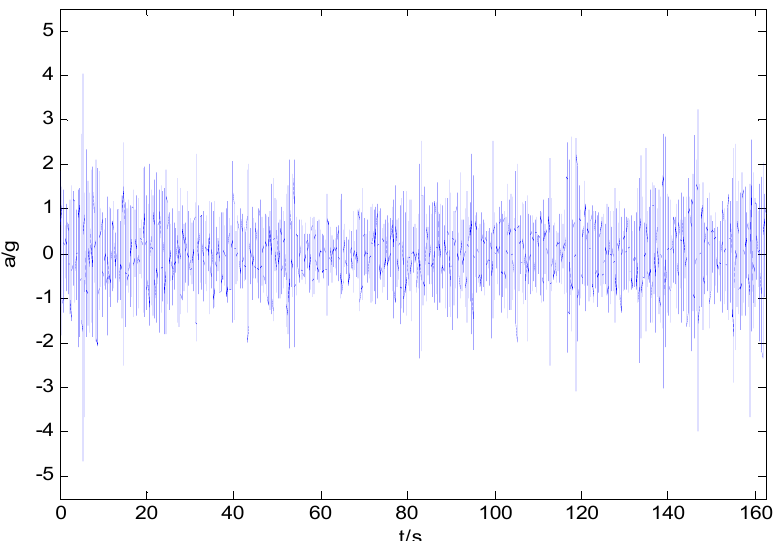
Figure 7. Original acceleration response time history at left front wheel axles.